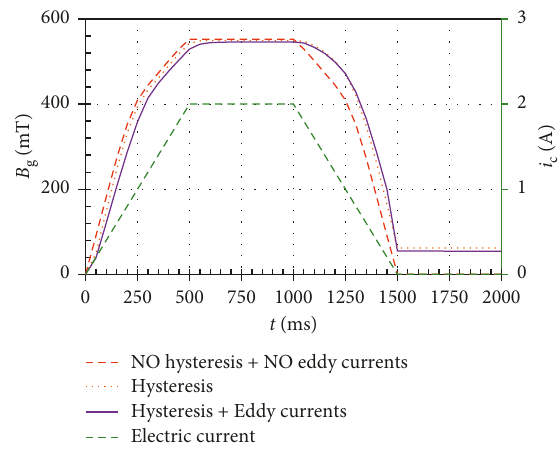
Figure 15: Time history: (gap) magnetic flux density, I